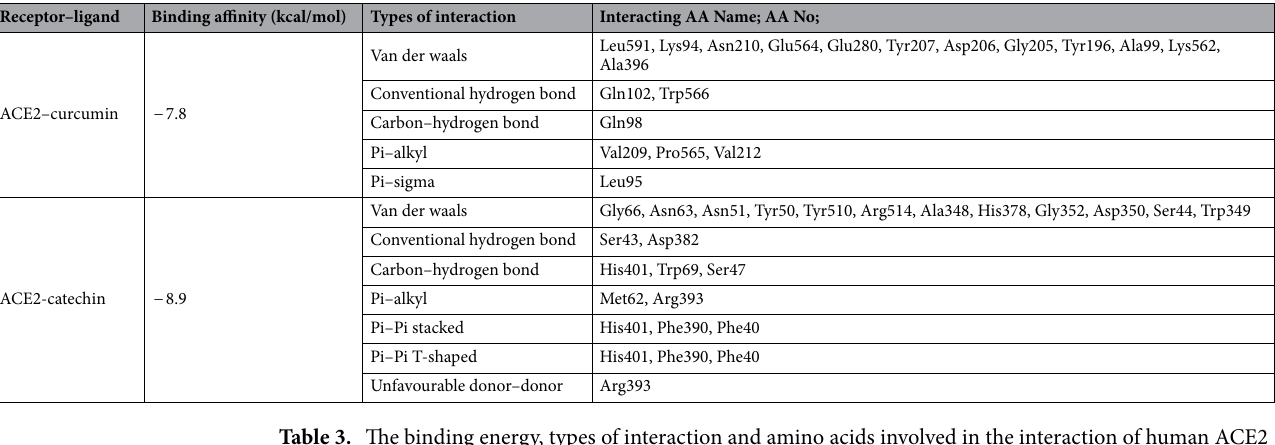
Interacting AA name AA No; For